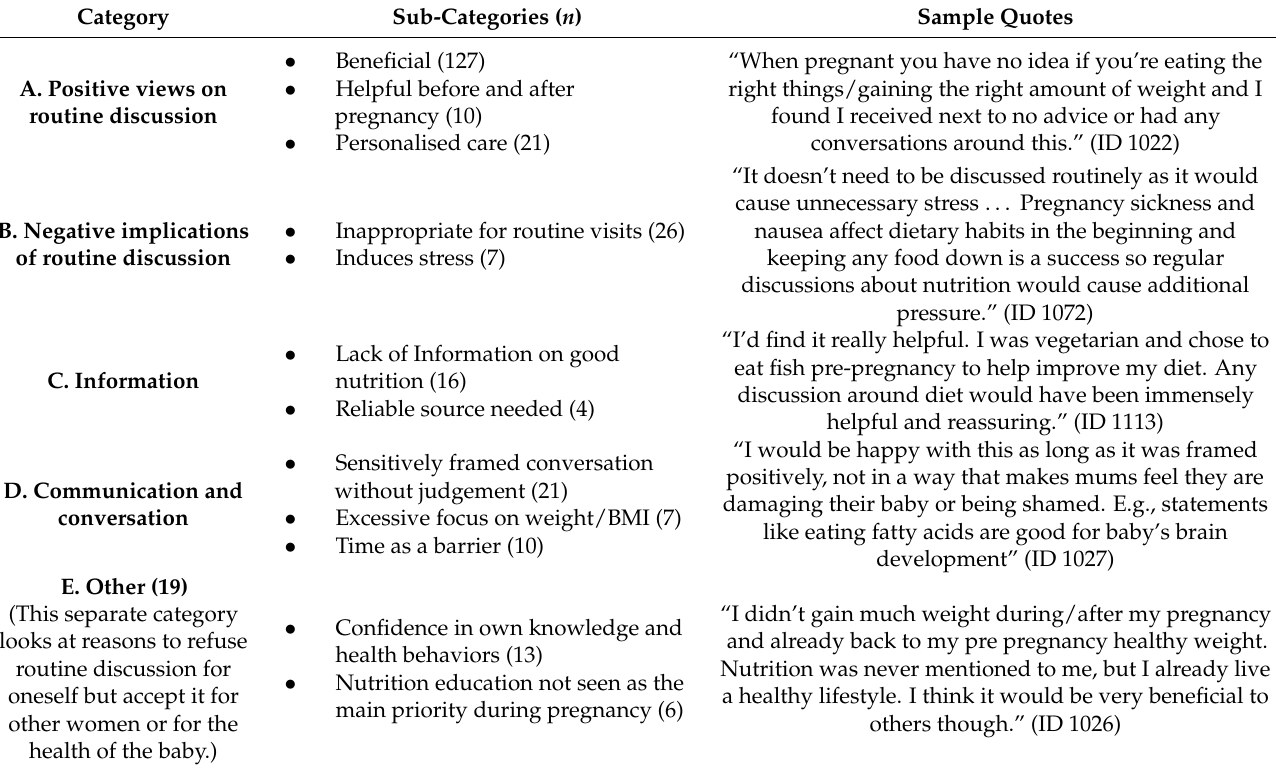
Table 3. Summary of content analysis of women’s views on routine discussion of nutrition.